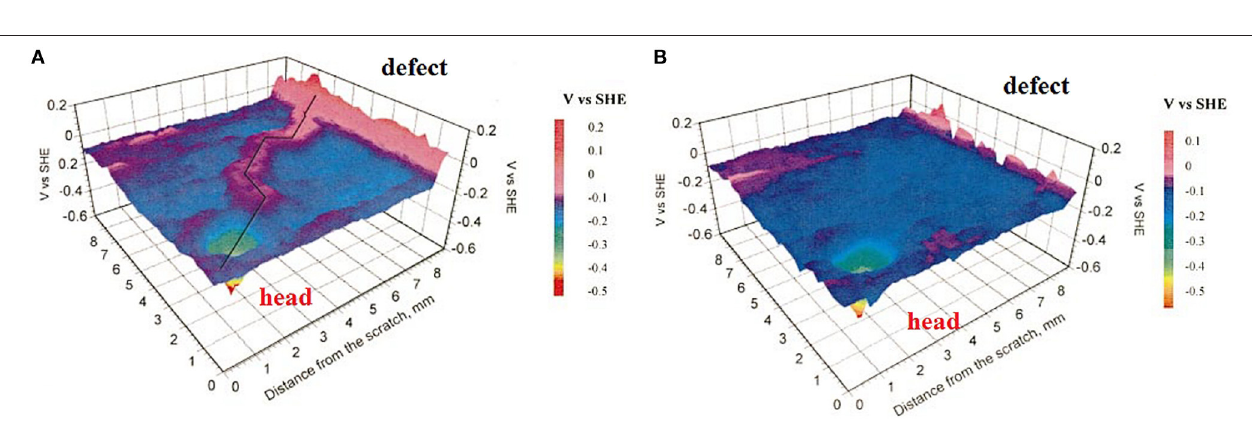
FIGURE 9 | SKP maps of the filament in electro coated AA6016 in air (A) and in argon (B) at 95% RH. Reproduced with permission from the Electrochemical Society ( Le Bozec et al., 2002) Copyright